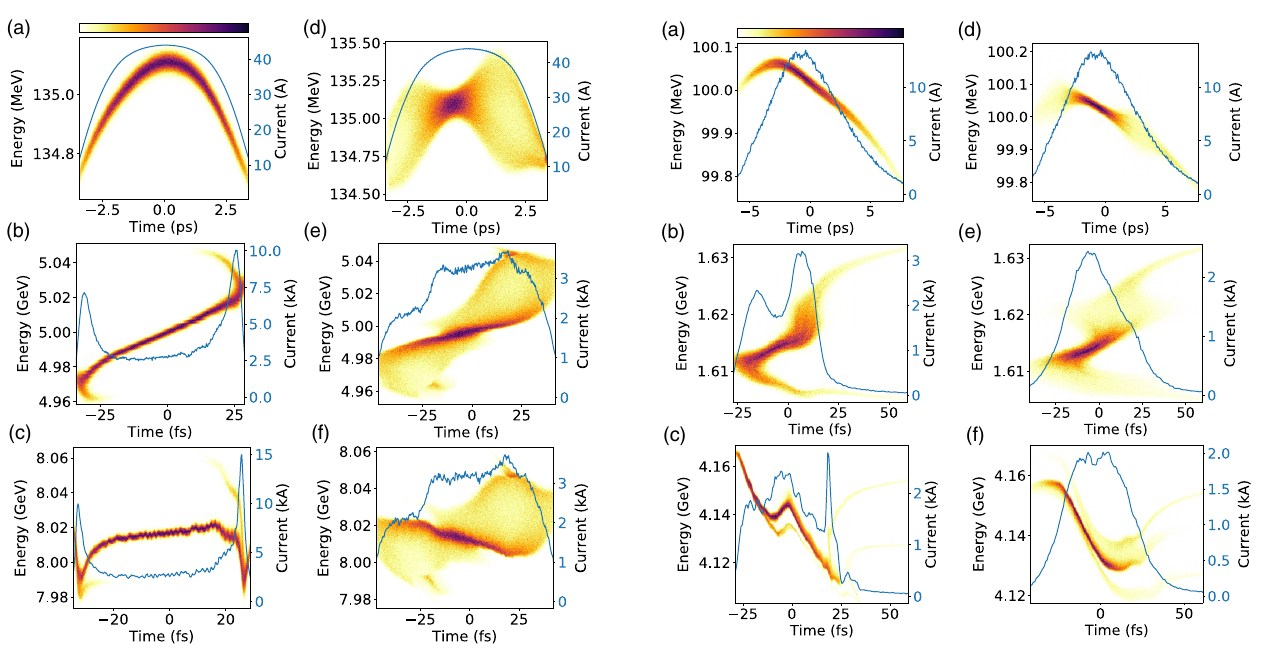
FIG. 10. Elegant simulations (a – c) without and (d – f) with laser heater horn collimation for the LCLS-II normal conducting, copper linac. Figures (a) and (d) show the longitudinal phase space after the laser heater with and without the pairs of Gaussian pulses. Figures (b) and (e) show the beam after the second bunch compressor. Figures (c) and (f) show the beam at the entrance of the hard x-ray undulators. The color bar above (a) shows the relative density for each plot. See Table